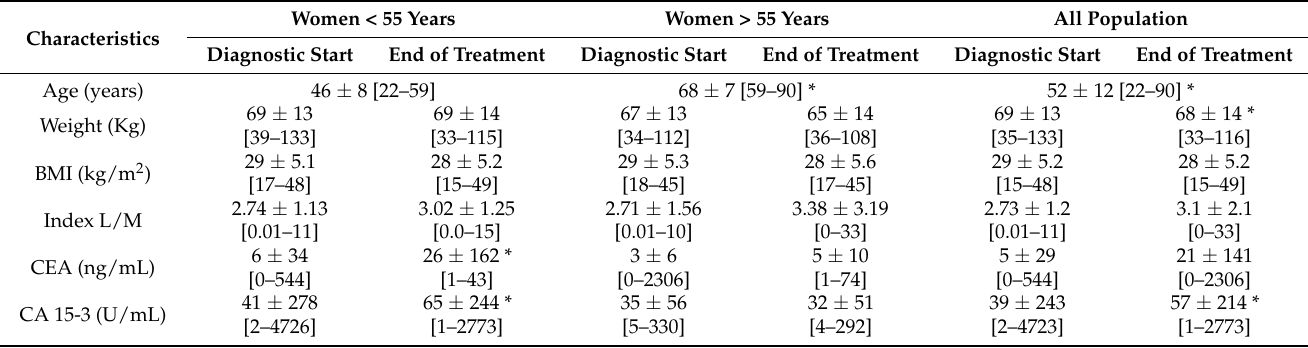
Table 1. Characteristics of Mexican women diagnosed with breast cancer and chemotherapy with respect to age